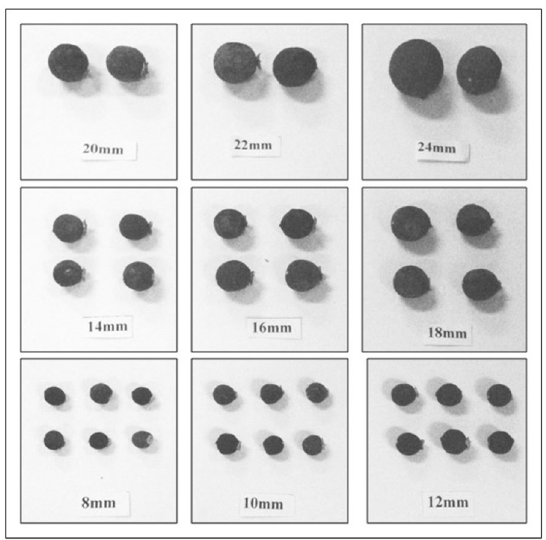
Figure 1. Dropped fruits of Citrus sinensis L. Osbeck (size 8–24